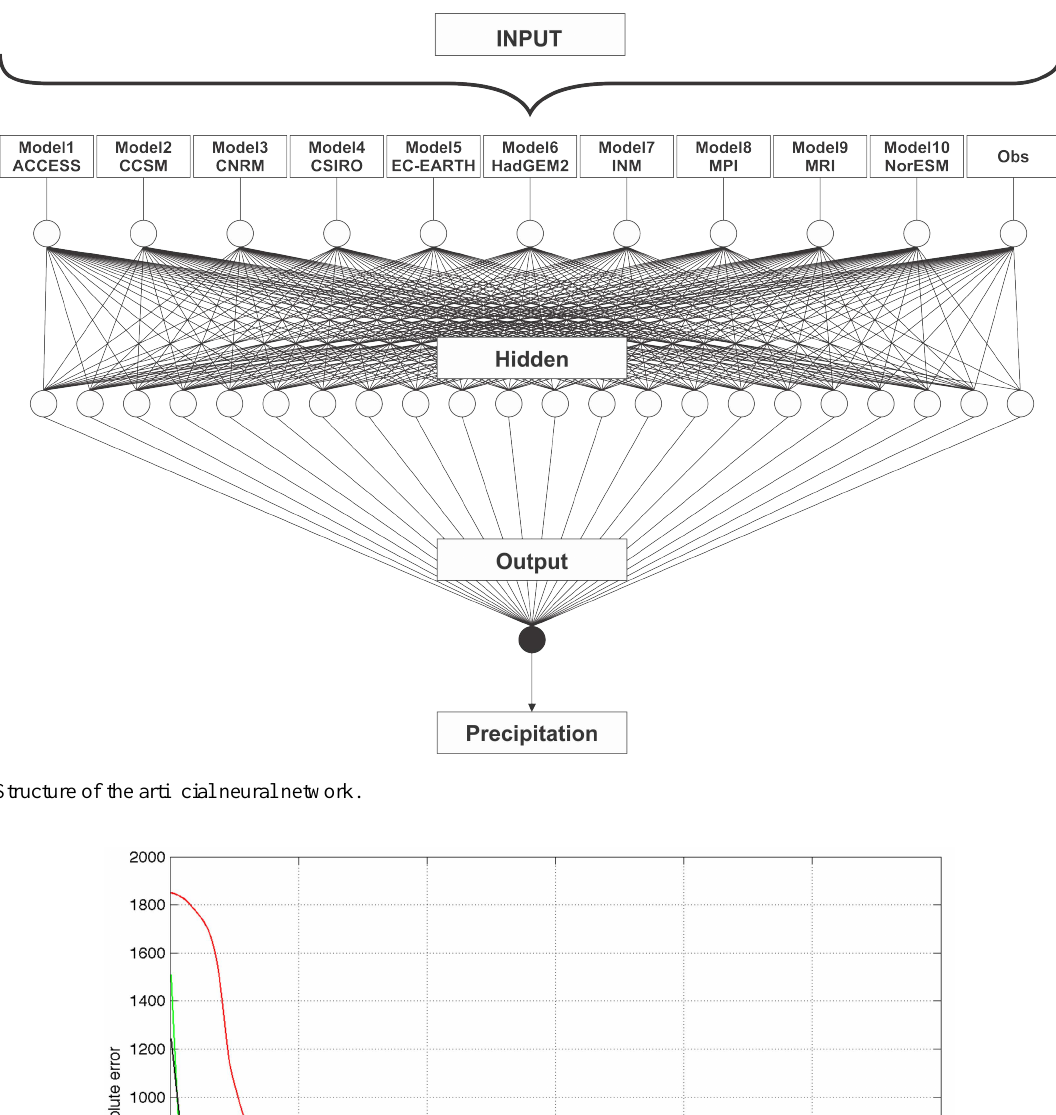
Figure 3. Absolute error as a function of the number of iterations; AMZ (green), NEB (red), and LPB (black). Continuous lines represent the summer period for each region, and the dashed lines represent